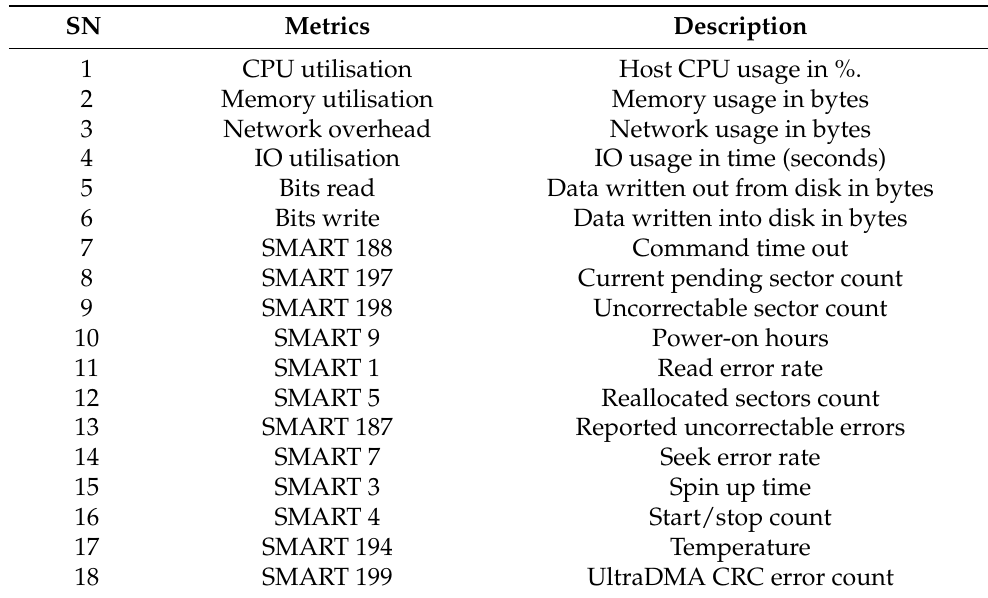
Figure 3. SMART 3 data distribution visualisation. Table 1. Selected metrics